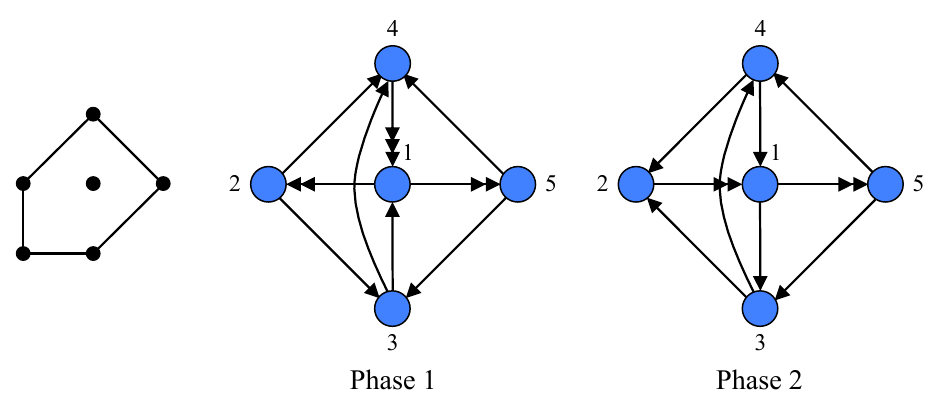
Figure 36. Toric diagram for dP 2 and quivers for its two toric phases. The two phases are connected by Seiberg duality on node 2.